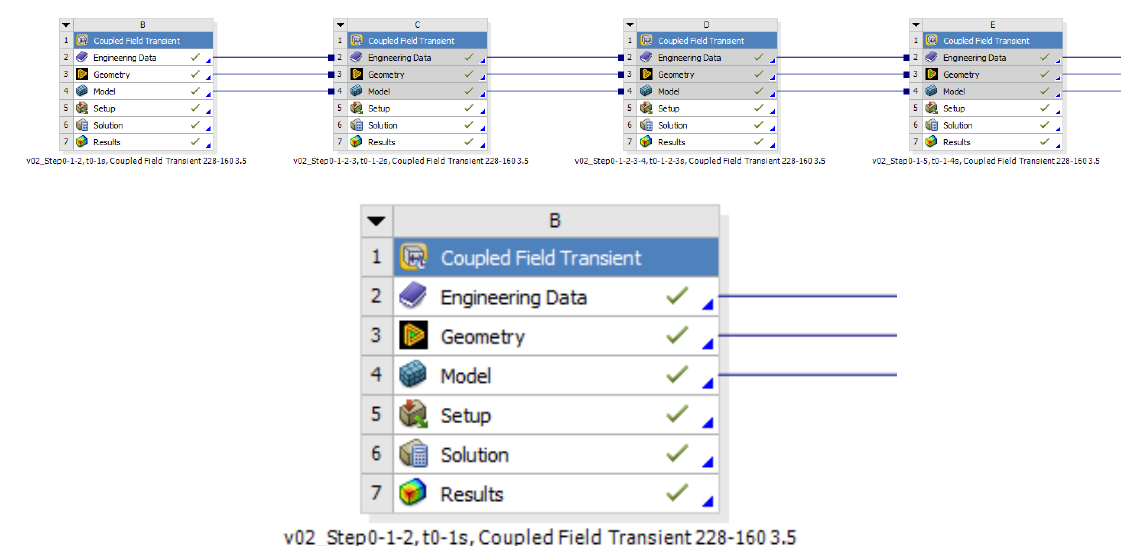
Figure 3. Workbench boxes for each second during the thermomechanical contact build-up.